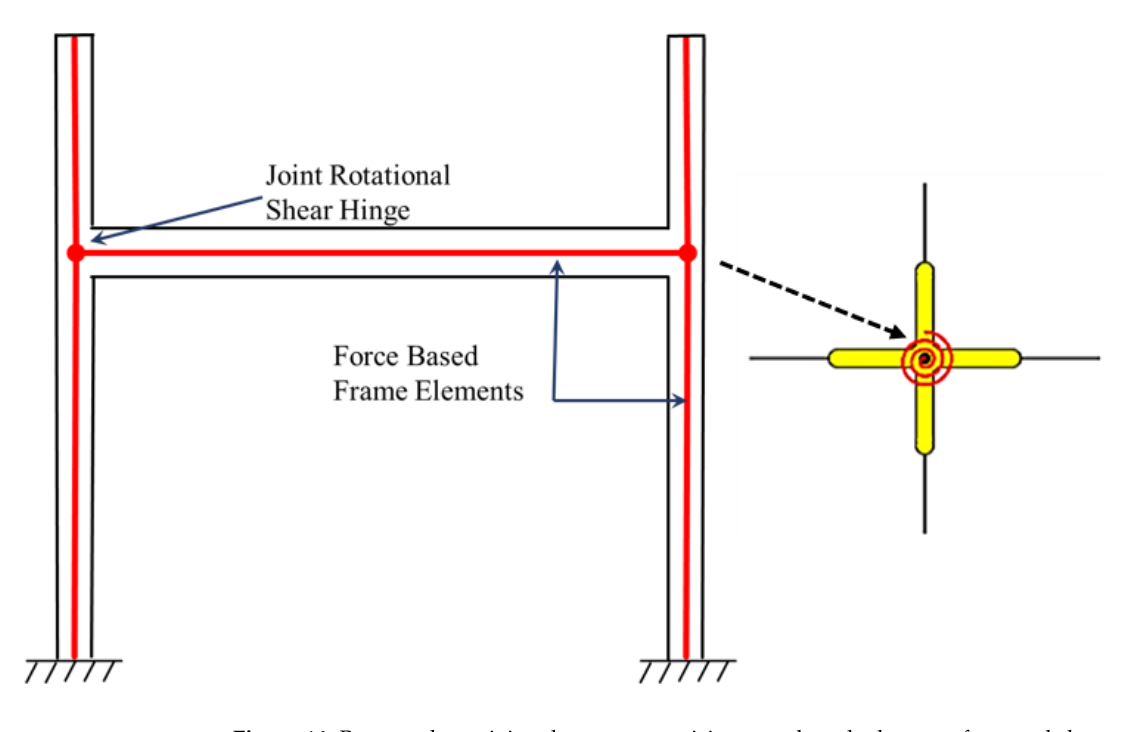
Figure 14. Beam–column joint element comprising zero-length elements for panel shear and lump Figure 14. Beam – column joint element comprising zero-length elements for panel shear and lump plasticity hinges for interface shear response, reproduced from literature [8]. plasticity hinges for interface shear response, reproduced from literature